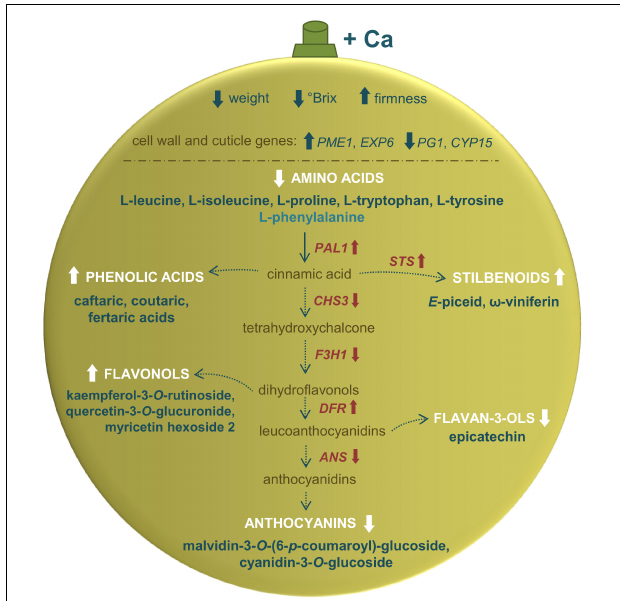
FIGURE 6 | Physiological, metabolic, and transcriptional changes driven by exogenous Ca in grape berries from vines cv. Loureiro. Arrows pointing upward indicate increase in comparison to control berries, while arrows pointing downward indicate decrease. The pathway was based on the information from Kyoto Encyclopedia of Genes and Genomes – KEGG